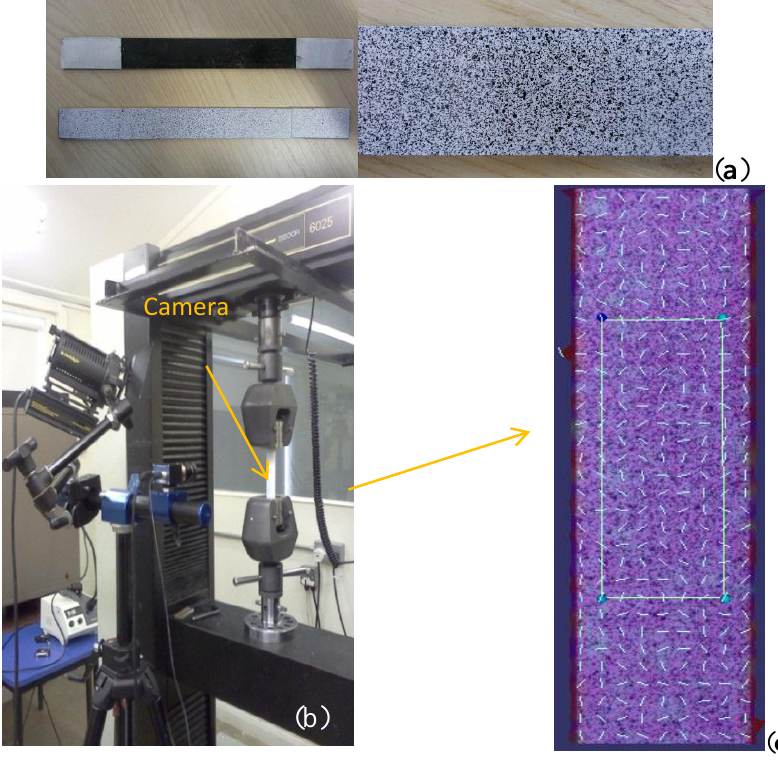
Figure 1. Digital image correlation (DIC) technique for tension ( a ) preparation of speckled samples; ( b ) DIC set-up; ( c ) evaluated gauge